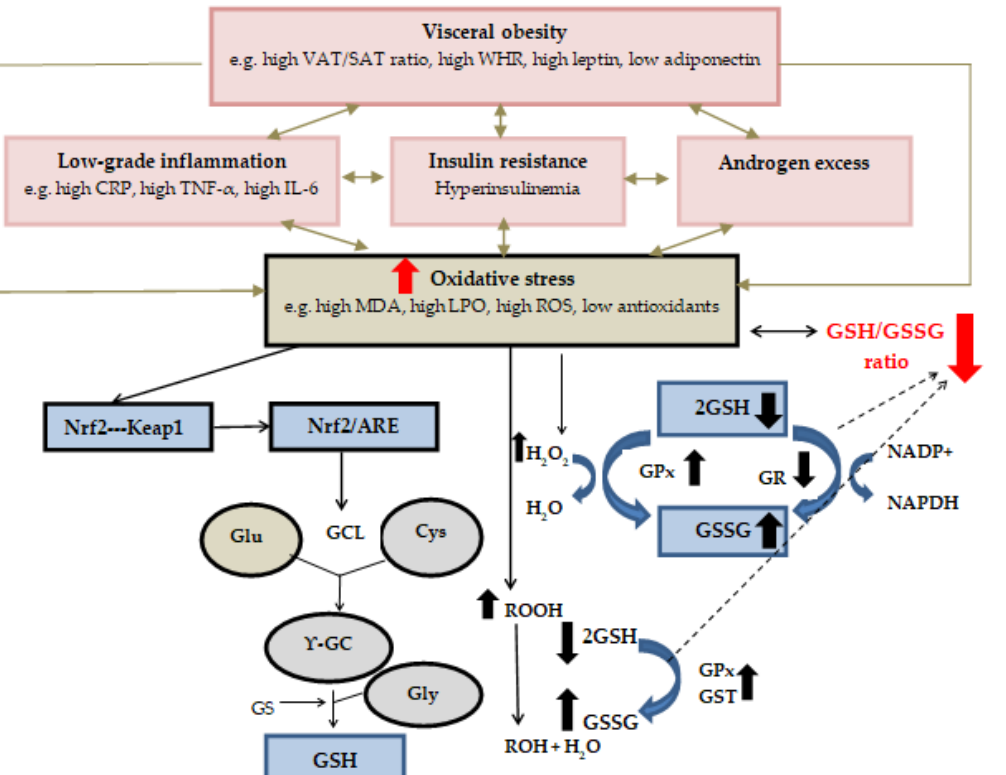
Figure 1. Possible links between oxidative stress and glutathione status and the Keap1-Nrf2 system action in women with polycystic ovary syndrome. Oxidative stress leads to the upregulation of the Keap1-Nrf2 system, resulting in the expression of, e.g., glutamate-cysteine ligase—the rate-limiting enzyme in glutathione synthesis. Oxidative stress dysregulated the glutathione regeneration enzy- matic process, resulting in decreased GSH/GSSG ratio levels. Nrf2 = nuclear factor erythroid-derived 2-like protein 2; Keap1 = Kelch-like ECH-associated protein 1; ARE = antioxidant response element; GCL = glutamate-cysteine ligase; GS = glutathione synthetase; Cys = cysteine; Glu = glutamate; Gly = glycine; γ GC = γ glutamyl-cysteine; GSH = reduced glutathione; GSSG = oxidized glutathione; GPx = glutathione peroxidase; GR = glutathione reductase; GST = glutathione transferase; GSH/GSSG ratio = index cellular redox; CRP = C-reactive protein; TNF- α = tumor necrosis factor α ; IL-6 = in- terleukin 6; VAT = visceral fat surface; SAT = subcutaneous fat surface; WHR = waist-to-hip ratio; MDA = malondialdehyde; LPO = lipid peroxidation; ROS = reactive oxygen